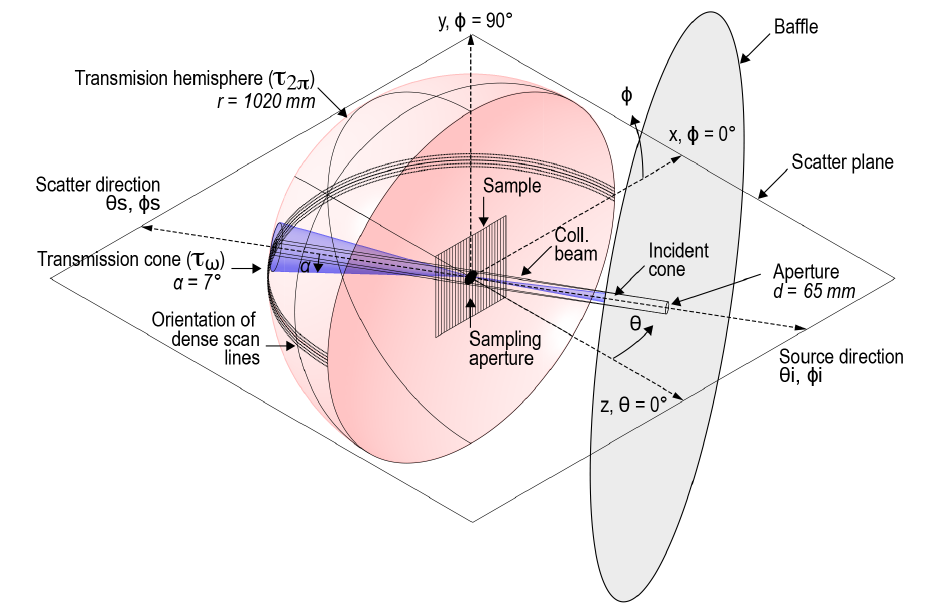
Figure 3. Schema of the Virtual Goniophotometer (VGP) and the geometry of the measured properties. Note that the light is emitted by a distant light source that is only defined by a direction and a central angle. The beam is formed by a baffle with an